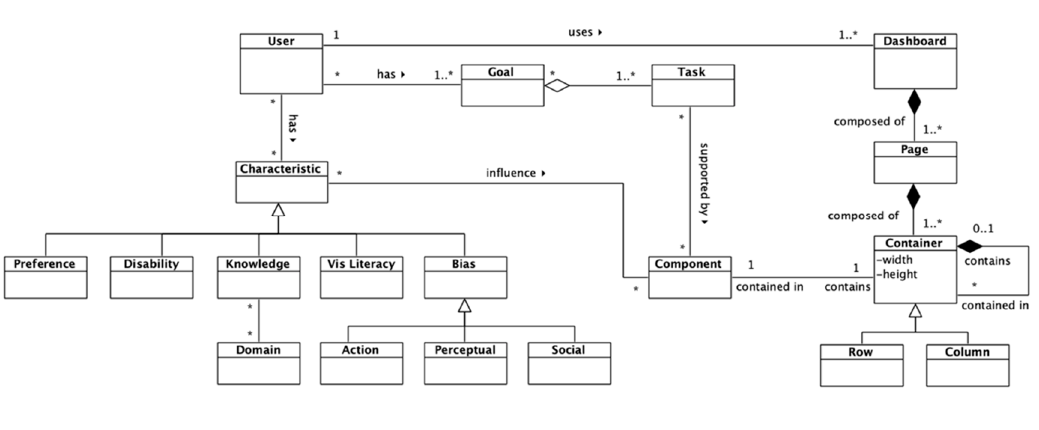
Figure 1. User and layout section of the dashboard meta-model